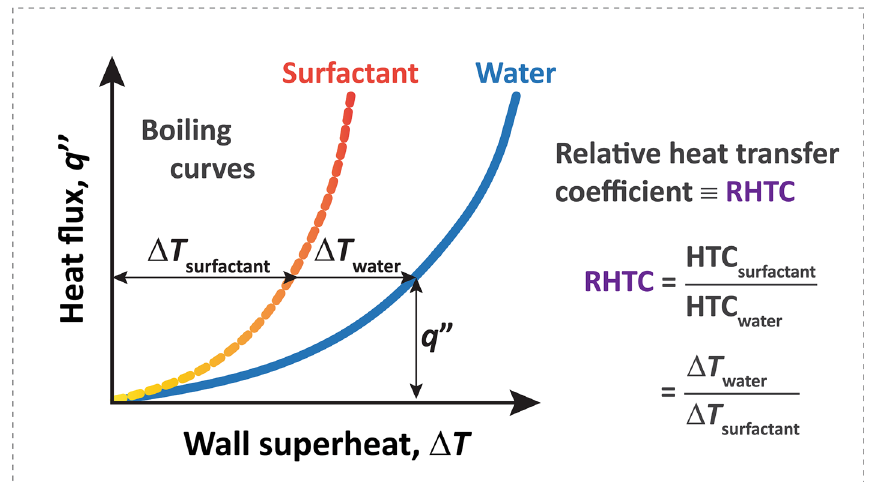
Figure 1. We quantify the degree of boiling enhancement with surfactants using a relative heat transfer coefficient (RHTC), defined as the ratio of HTC with surfactant over HTC of pure water at a given heat flux.